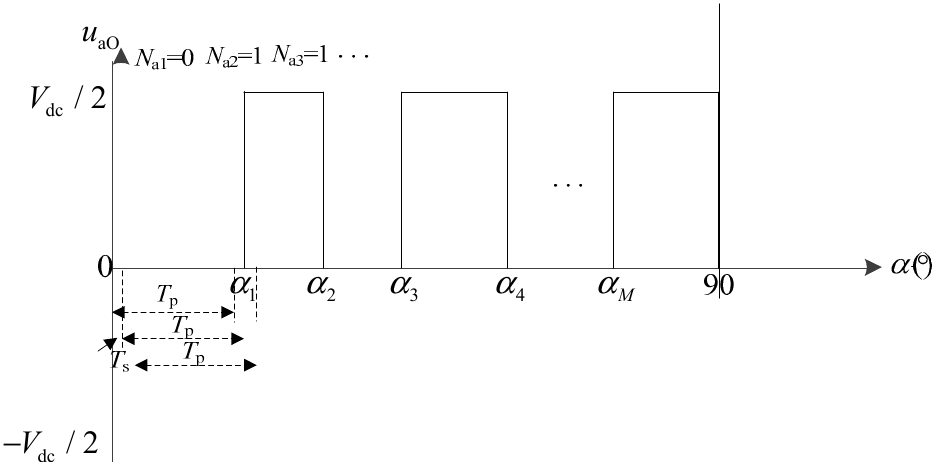
Figure 5. Schematic diagram of T s , T p and the number of pulse adjustment.